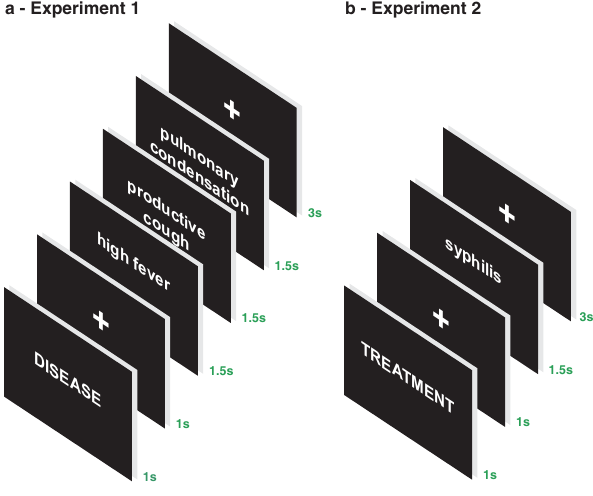
Figure 1. Temporal structure of the experiments. ( a ) Experiment 1: The temporal structure of a trial, totaling 9.5 s, comprised: 1- task signaling - diagnosing or naming - with the presentation of the words ‘DISEASE’, ‘ANIMAL’, or ‘OBJECT’ followed by a central cross in a black screen, totaling 2 s of foreperiod; 2- presentation of three pieces of information; 3- an additional period with a central cross in a black screen. ( b ) Experiment 2: The temporal structure the trial, totaling 6.5 s, was the following: 1- task signaling - disease diagnosis or treatment prescription - with the presentation of the words ‘DIAGNOSIS’ or ‘TREATMENT’ followed by a white central cross in a black screen, totaling 2 s of foreperiod; 2- presentation of the cue for the task, a diagnostic information or the name of a disease; 3- an additional period with a central white cross in a black screen. In this example, the expected response to syphilis is ‘penicillin’; its